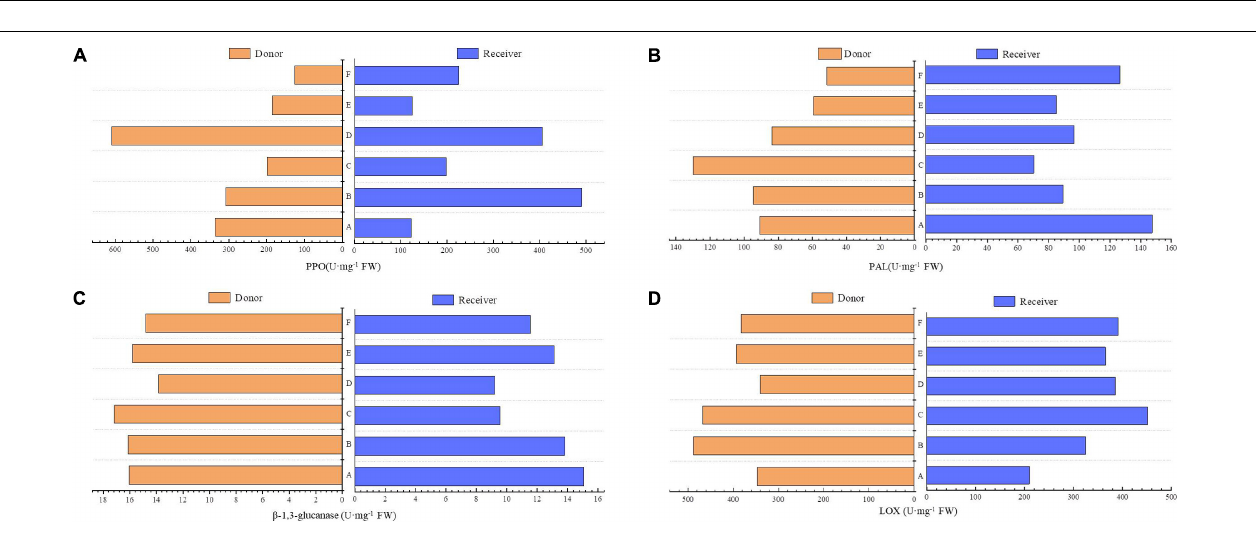
FIGURE 4 | Effects of AMF on the ratio of C and N content of donor and received plants. Data are mean ± SD (n = 3).